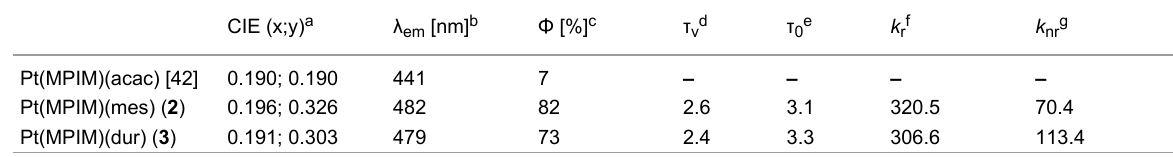
Table 1: Photoluminescence data of complexes 2 and 3 (2 wt % in PMMA, λ exc = 320 nm) and literature-known compound Pt(MPIM)(acac).